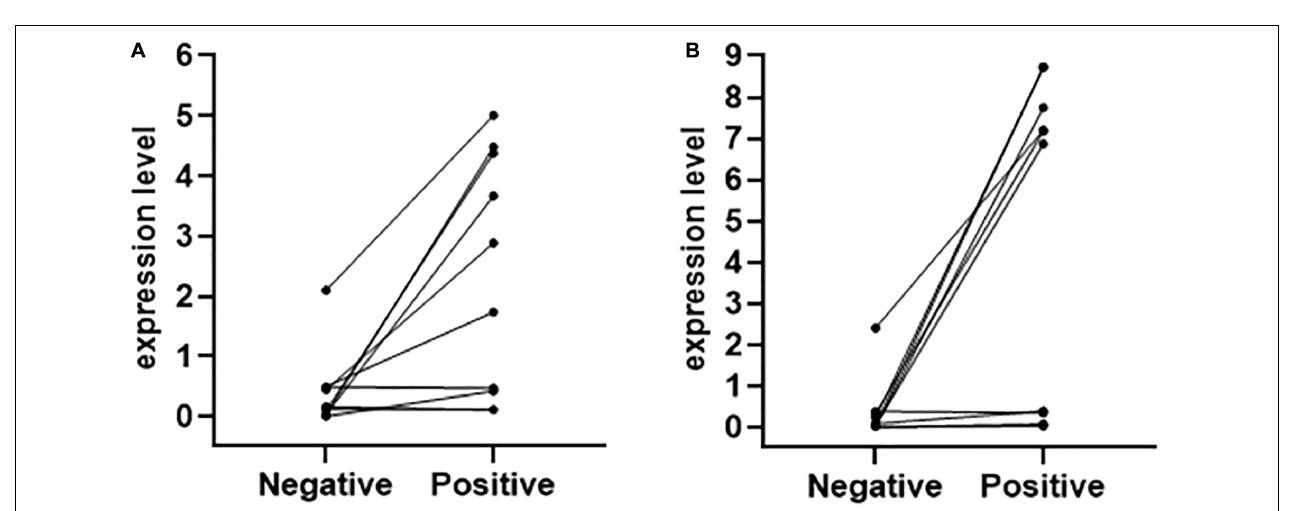
FIGURE 3 | ROC curve analysis for the ASdes (A) , MTB-miR5 (B) and the combined two sRNA (C) panel in the small extracellular vesicle isolated from serum of healthy controls (HC), active pulmonary TB patients (TB), and community-acquired pneumonia (CAP) patients.